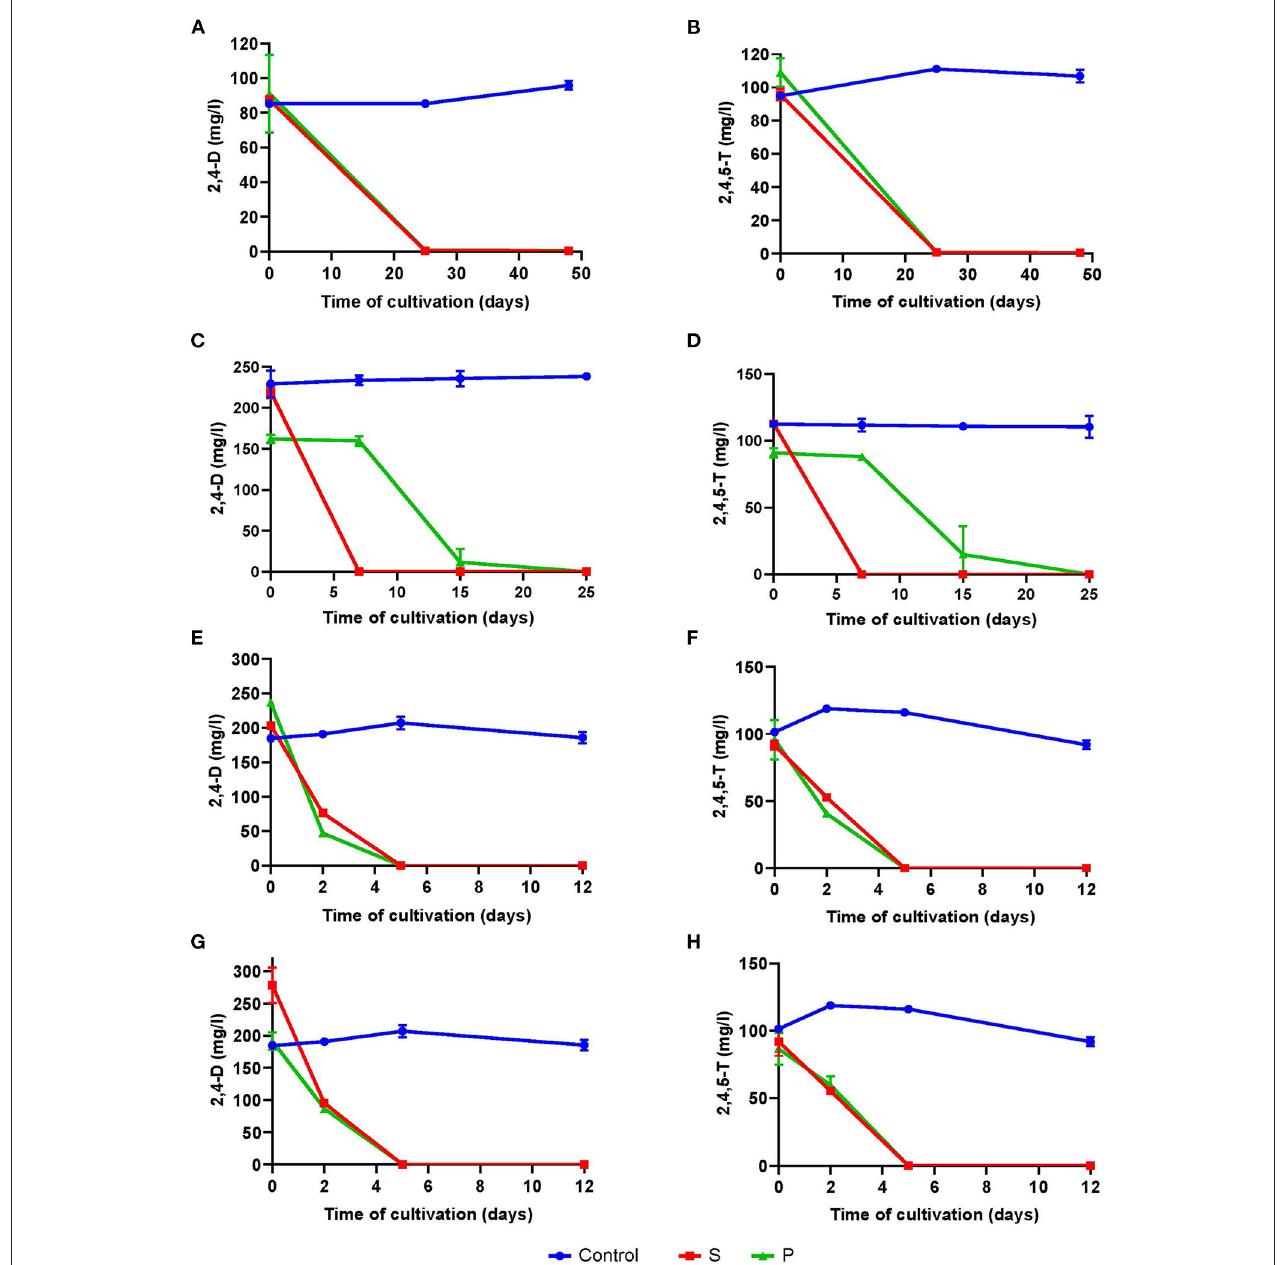
FIGURE 3 | Degradation of 2,4-D (A,C,E,G) and 2,4,5-T (B,D,F,H) in mineral salts medium inoculated with T1 soil in the 1st enrichment (A,B) , degradation profiles of the 2nd enrichment (C,D) , of the 3rd enrichment (E,F) , and of the 2nd enrichment after addition of an extra spike of the herbicides (G,H) during a 12-day cultivation period. Each point and shape represent the average of three independent measurements, and the error bars are their standard deviations. Blue circles, control with sterilized soil (see “Soil Sampling and Culturing Conditions” in Materials and methods section); green triangles, herbicides in powder form; red squares, herbicides dissolved in